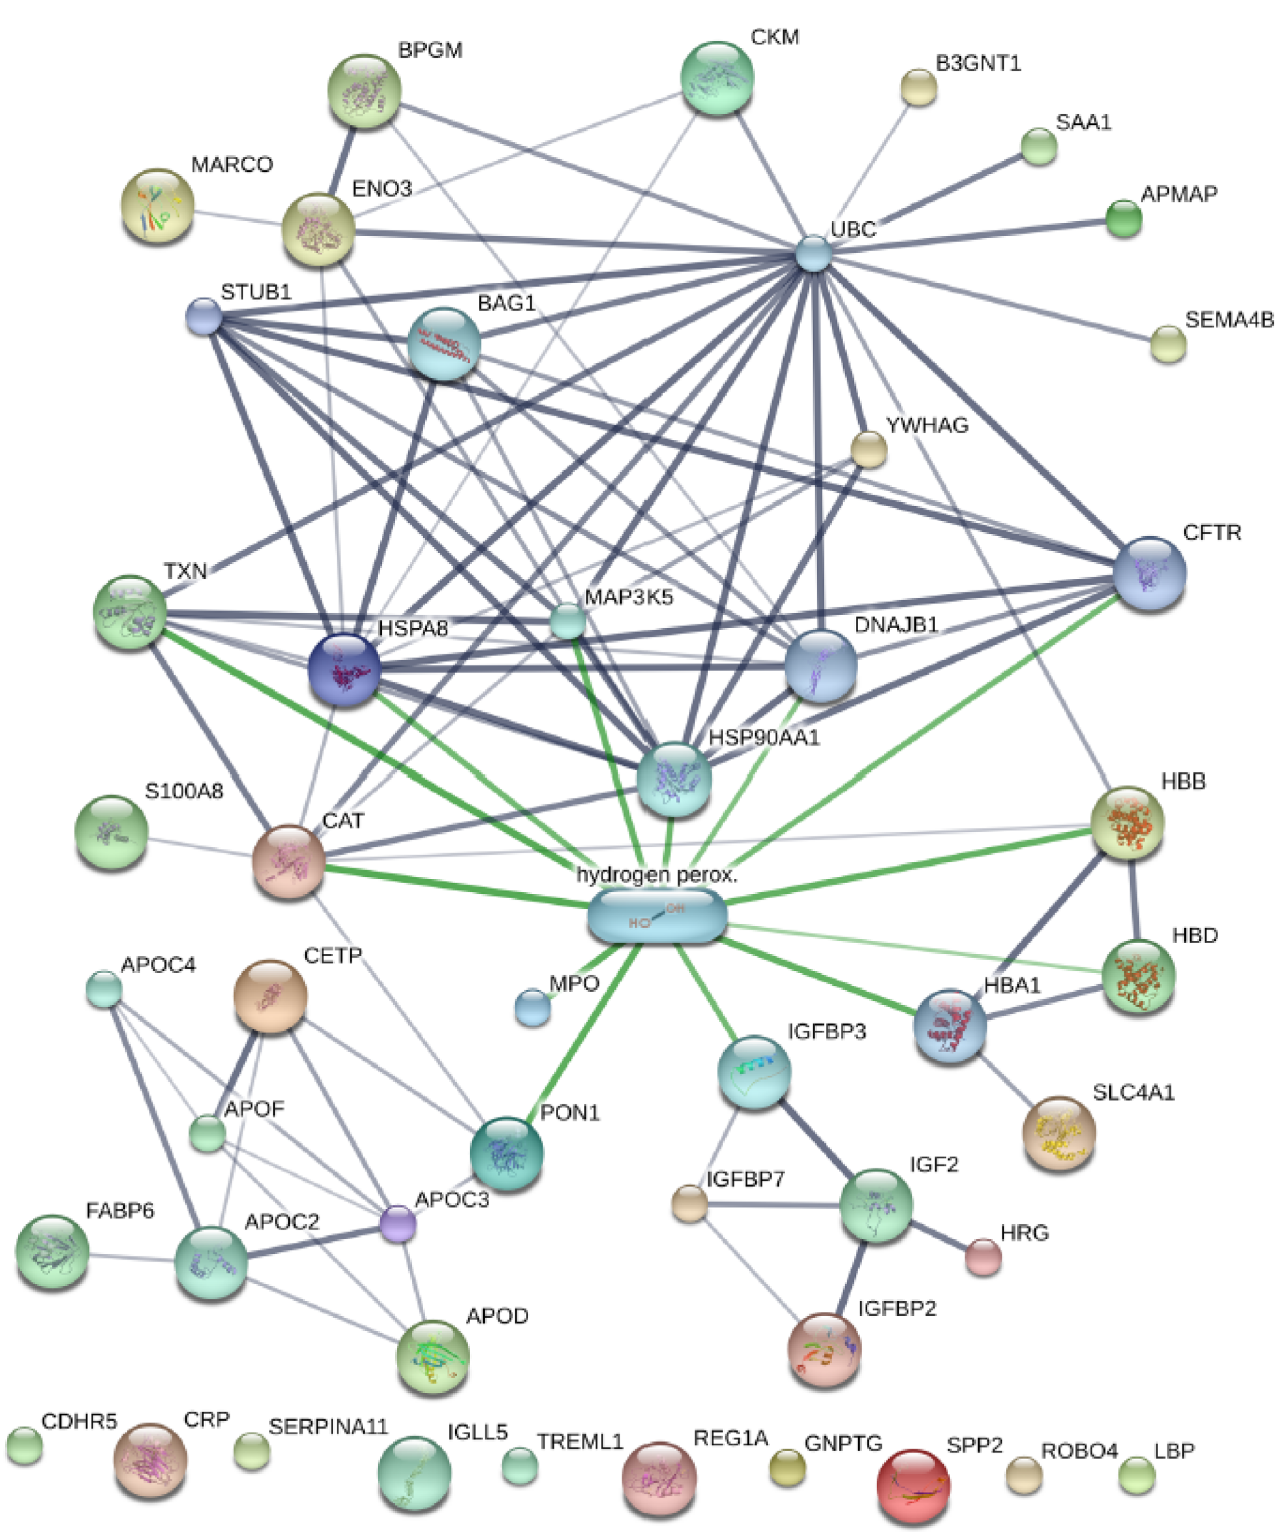
Figure 5. The network of protein and drug compound interactions. Thirty DAPs were found to be directly or indirectly associated with hydrogen peroxide. Colored nodes represent query DAPs, and small nodes represent those with an unknown 3D structure. Large nodes represent proteins with a known or predicted 3D structure. The weight of edges indicates the confidence score, wherein a thicker line indicates stronger association. Protein-protein interactions are represented by a gray edge, while chemical-protein interactions are depicted in